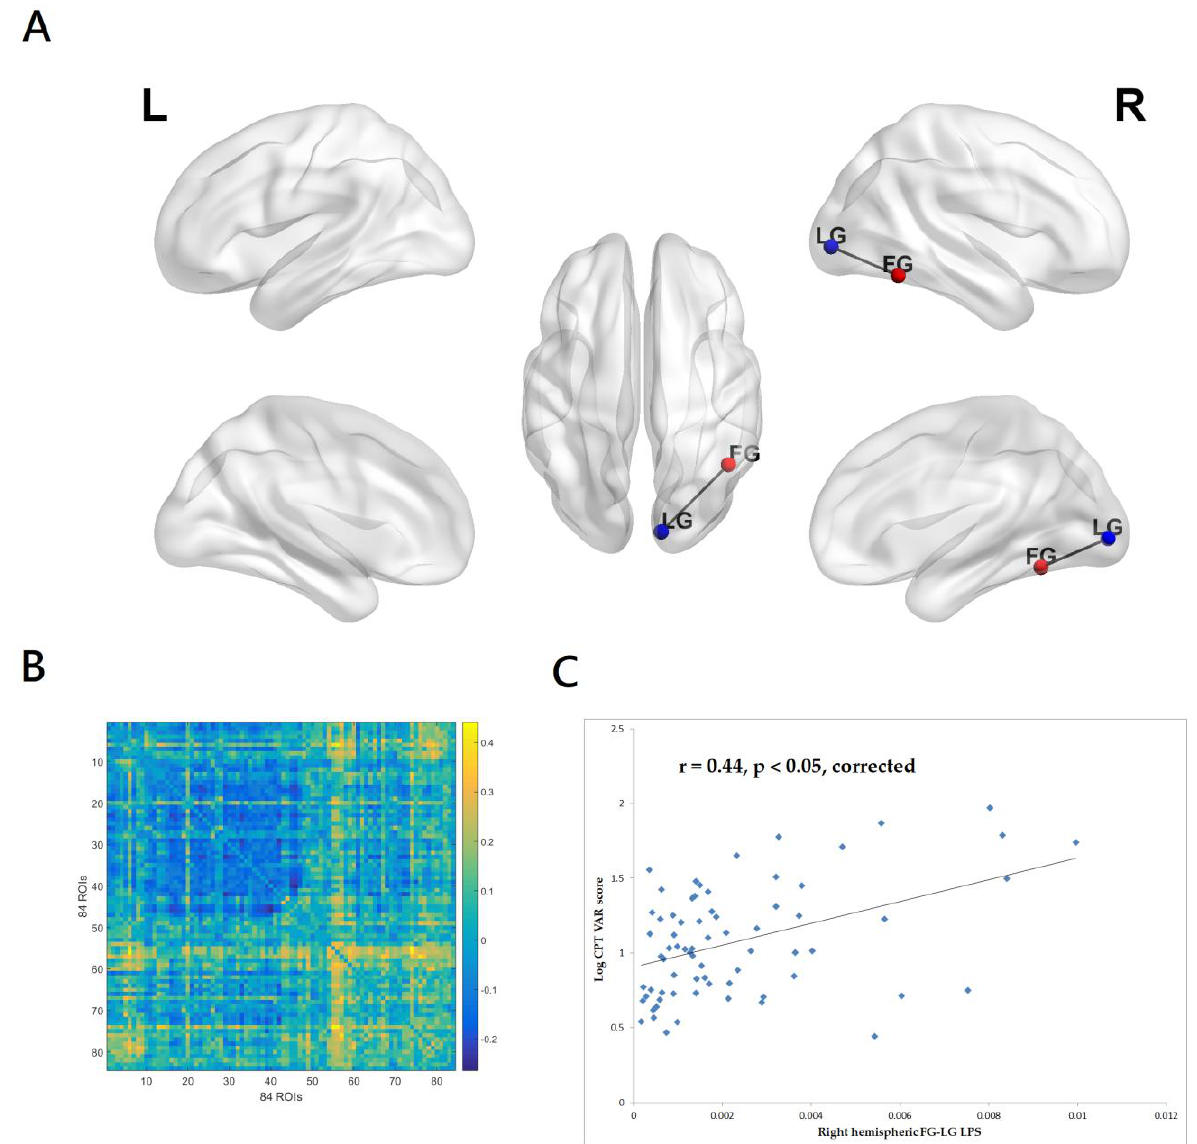
Figure 1. ( A )The CPT-II VAR score was significantly associated with the beta-band (13–32.5 Hz) LPS between right hemispheric fusiform gyrus (FG) and lingual gyrus (LG). eLORETA and BrainNet Viewer were used to create the figure. ( B ) The matrix of the correlation coefficients for the value of beta-band lagged phase synchronization (LPS) of all pairs from 84 regions of interest. ( C ) Patients with higher CPT-II VAR scores had greater beta-band EEG functional connectivity between right hemispheric FG and LG. The linear regression line was shown to model a linear trend seen in the scatterplot.